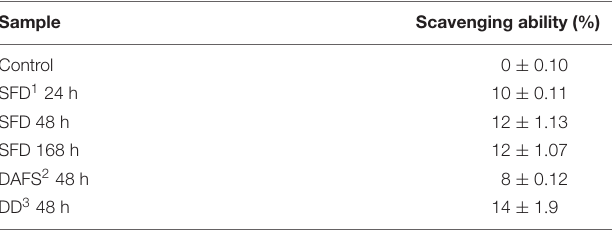
TABLE 2 | Scavenging ability of dyed polyamide fabrics with violacein via SFD, DAFS, or DD.